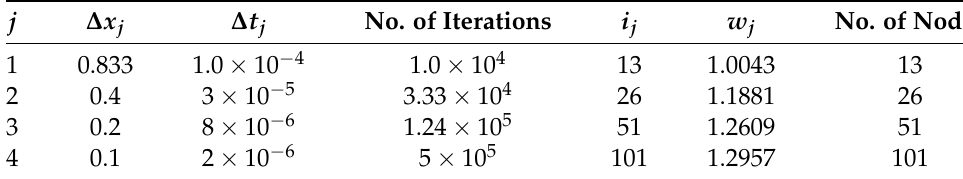
Table 2. Grid Convergence Index